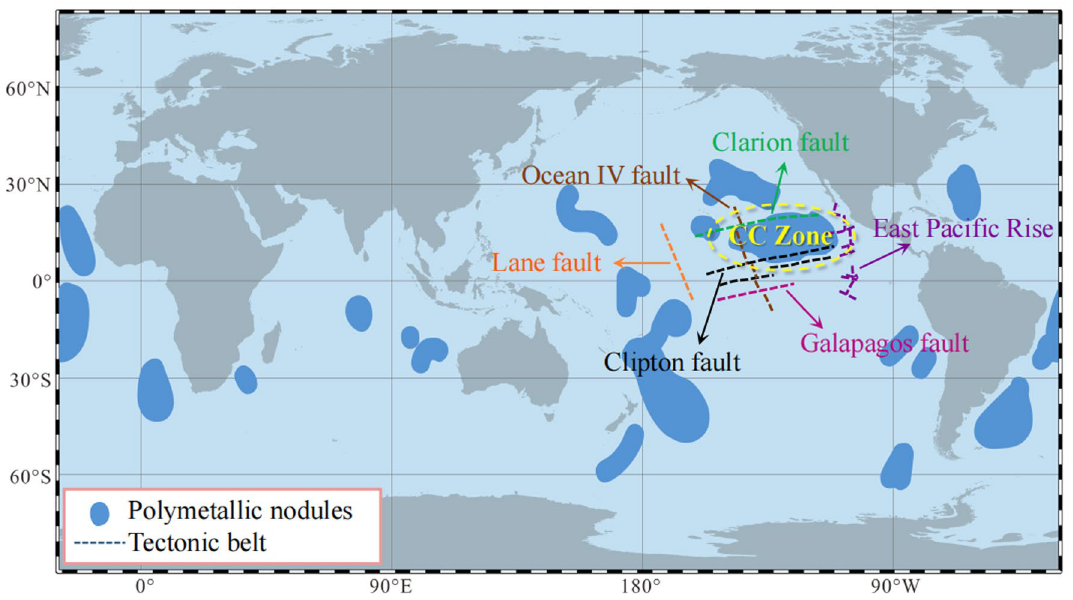
Fig. 16 Tectonic belt surrounding the CC zone (modified from Zhang et al. 2001; Li 2008; Liu et al. 2009; Hein 2016; Miller et al. 2018)